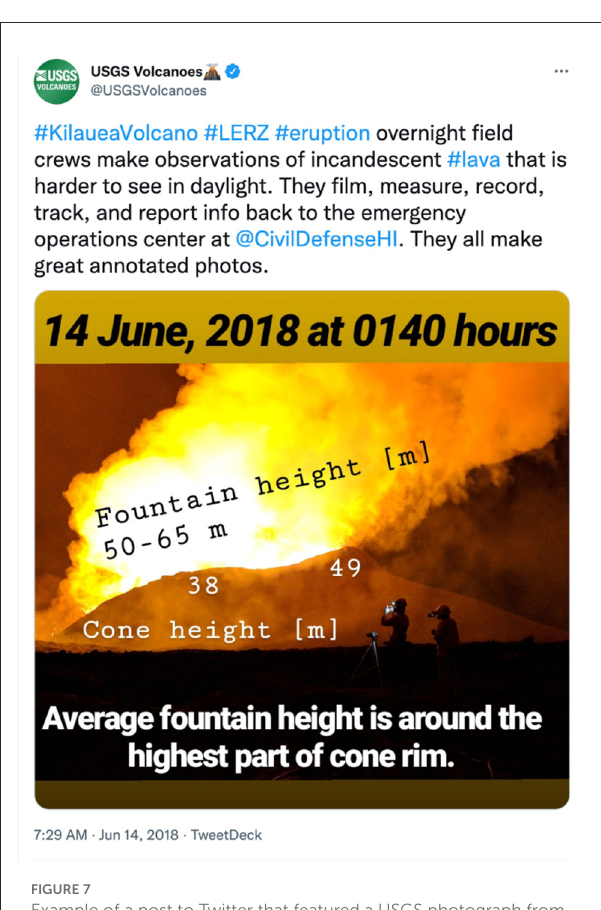
FIGURE7 Example of a post to Twitter that featured a USGS photograph from the field with accompanying scientific information and educational